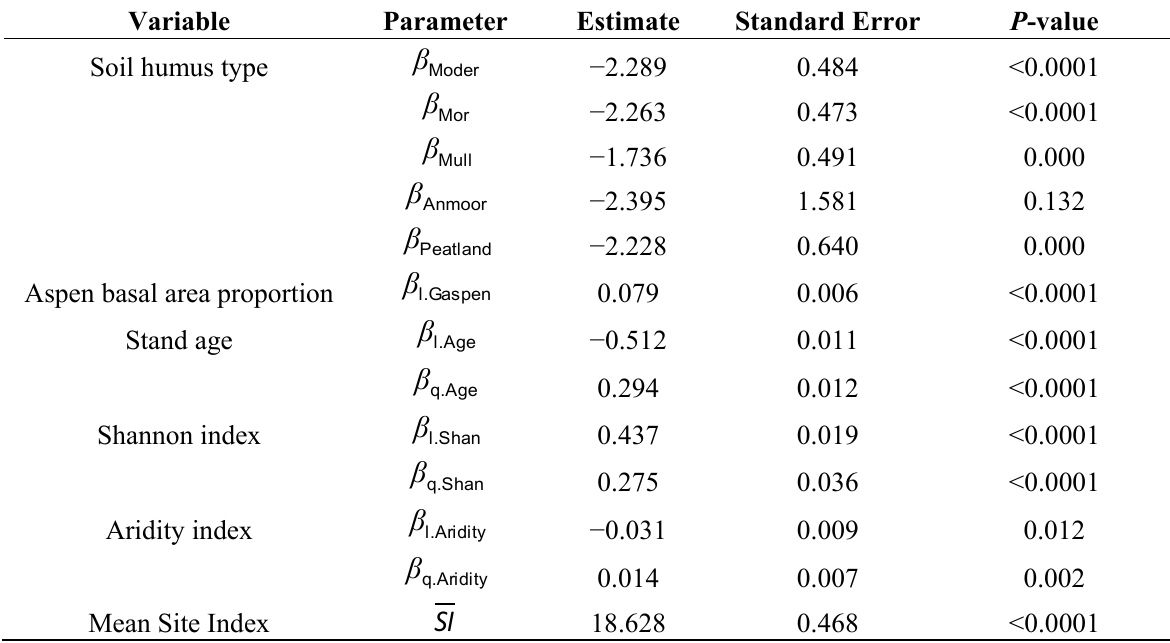
Table 1. Parameter values of model